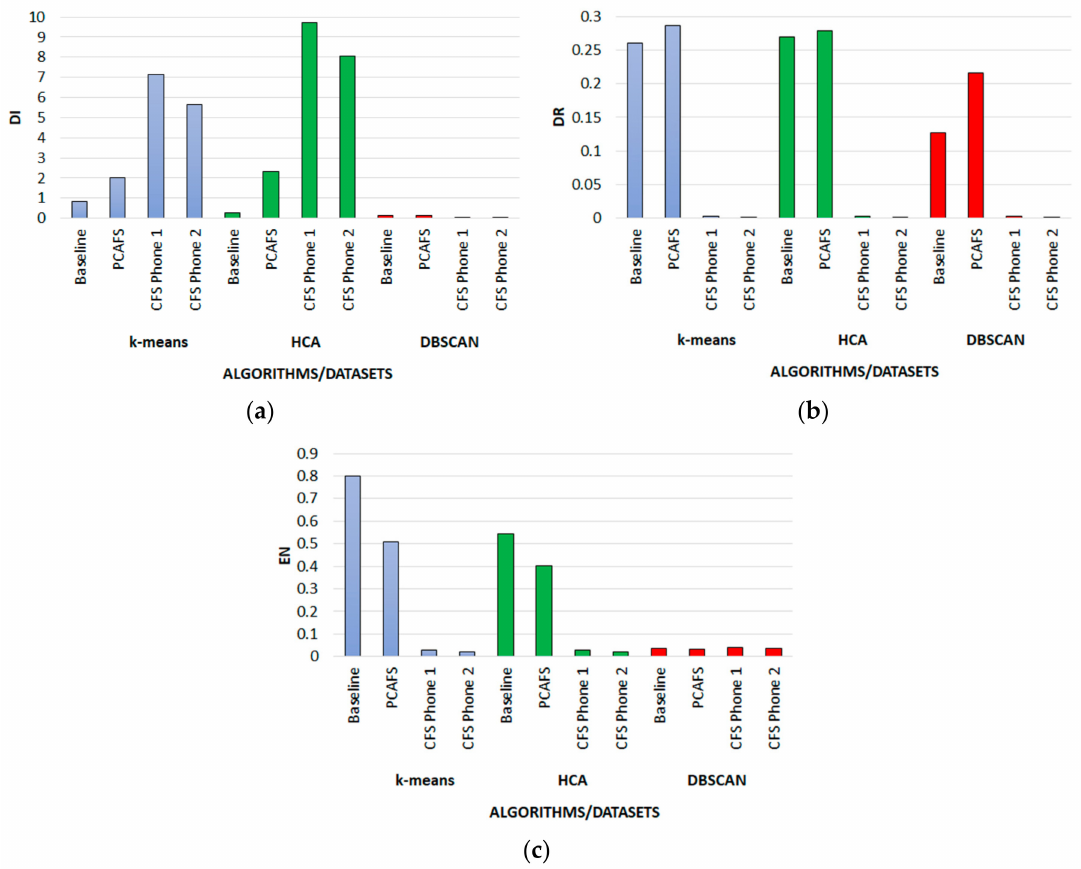
Figure 6. Clustering validation of the Phone datasets that illustrates ( a ) Dunn Index (DI), ( b ) distance ratio (DR), and ( c ) entropy (EN). PCAFS: Principle component analysis feature selection; CFS: correlation feature